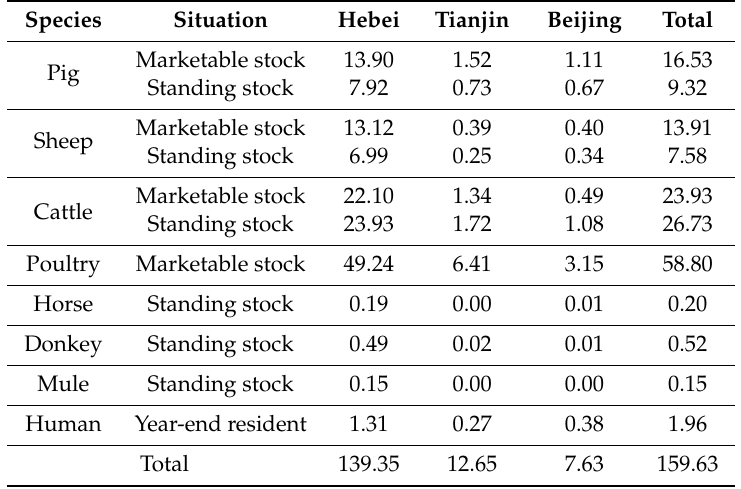
Table 7. The estimation of human, livestock, and poultry waste production (10 6 tons).